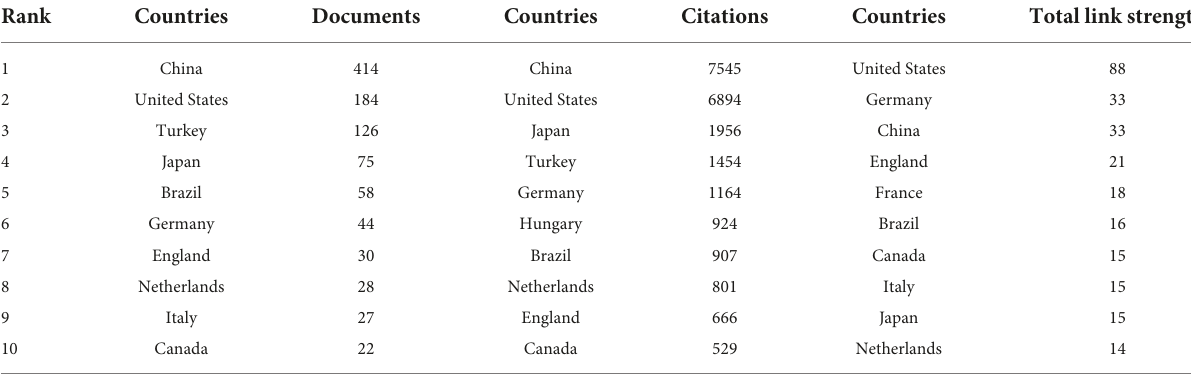
TABLE 1 Top 10 countries in terms of number of publications, frequency of citations, and total association intensity. Rank Countries